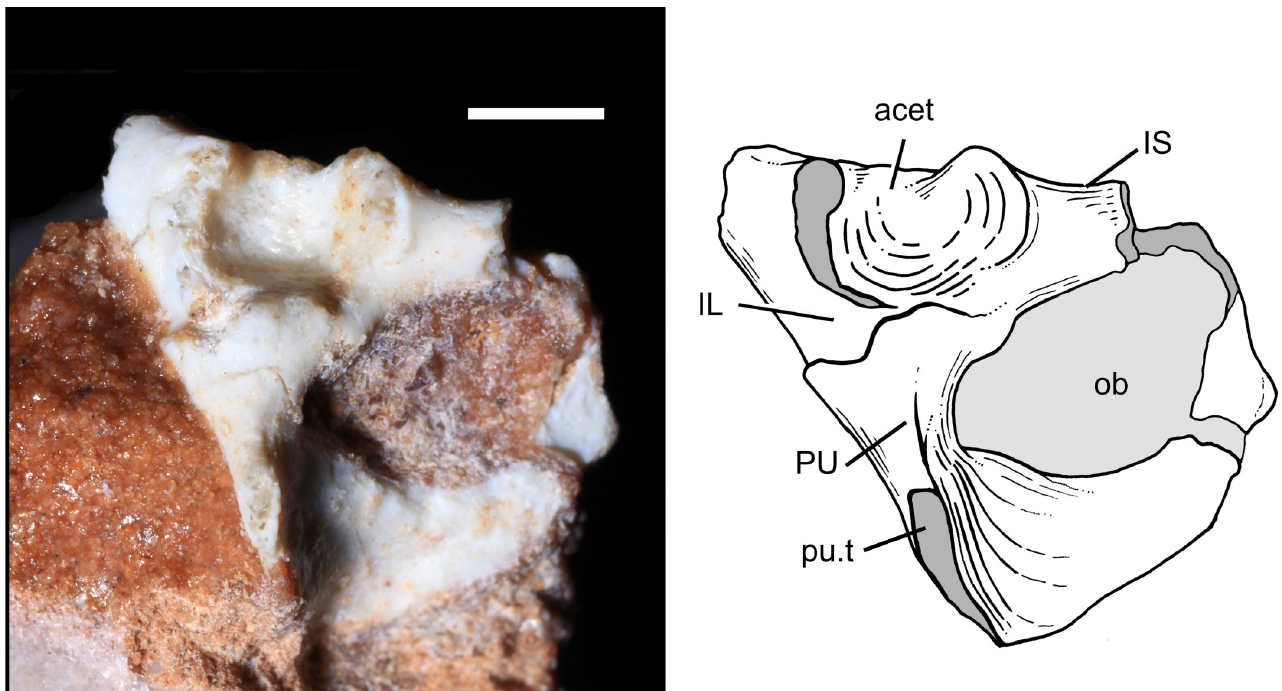
Fig 5. Photography and drawing of the left acetabulum of Brasilodon quadrangularis (UFRGS-PV-1043-T), in lateral view. Abbreviations: acet , acetabulum; IL , ilium; IS , ischium; ob , obturator foramen; PU , pubis; pu.t , pubic tuberosity. Scale bar = 2 mm.